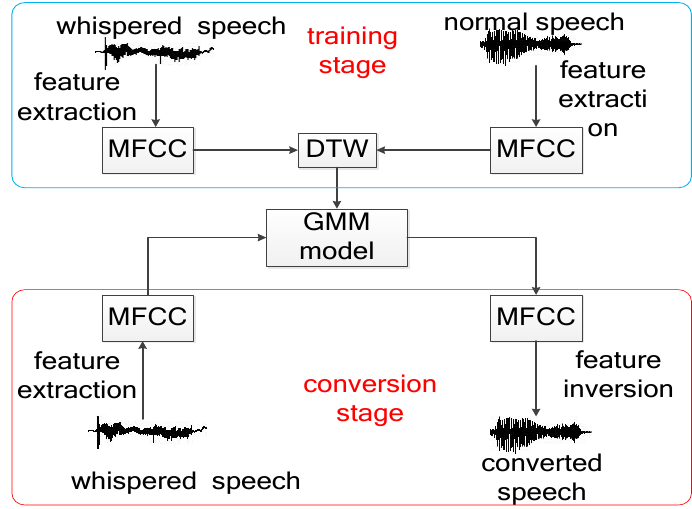
Figure 1. Flow chart of whispered speech – normal speech conversion.